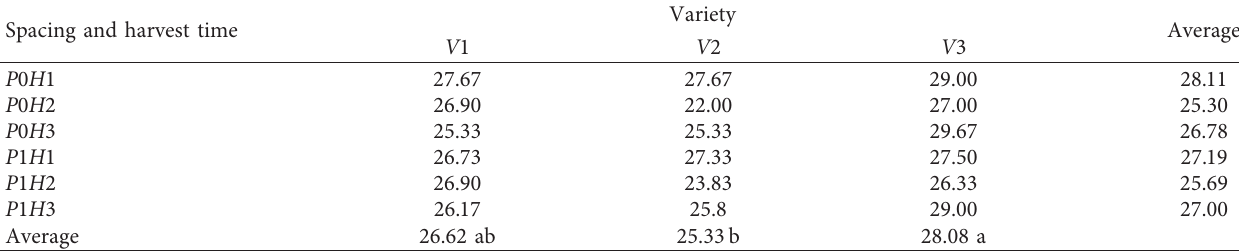
Table 4: Cob length (cm) of sweet corn plants of different varieties and at different harvest times.